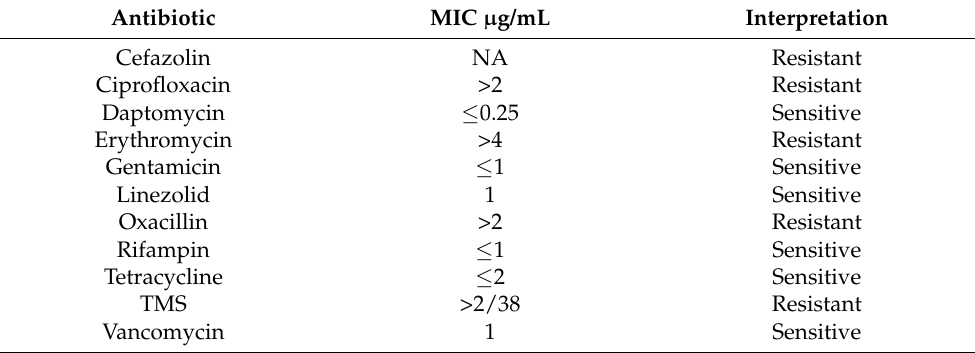
Table 1. S. epidermidis Susceptibility